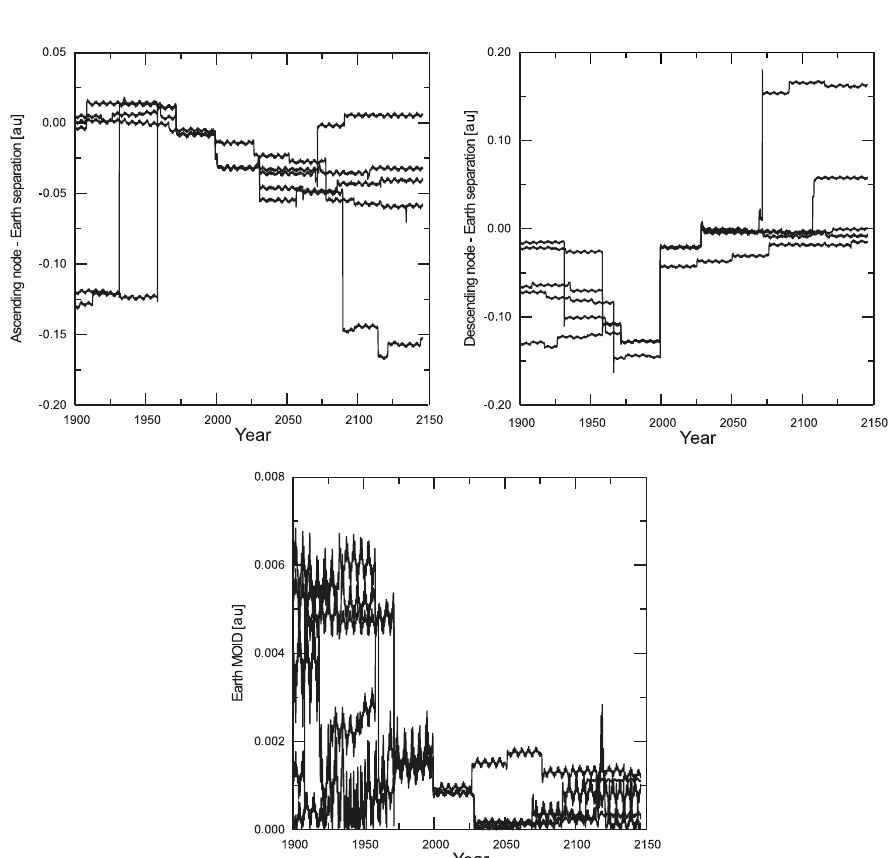
Fig. 3. Asteroid 2000 SG344. Ascending and descending { Earth separation, and Earth MOID. mean anomaly M . The orbits are computed from all 31 astrometric positions and are based on observations from 1999 May 15.20482 UTC to 2000 October